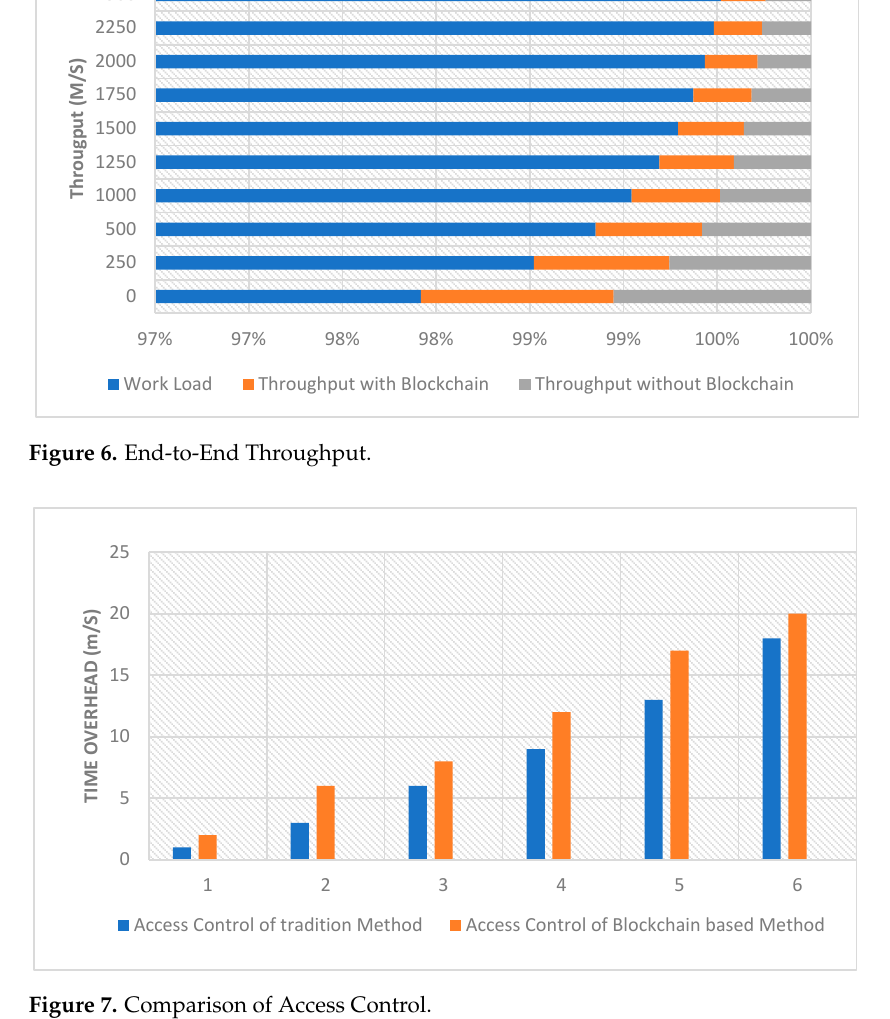
Figure 6. End-to-End Throughput .